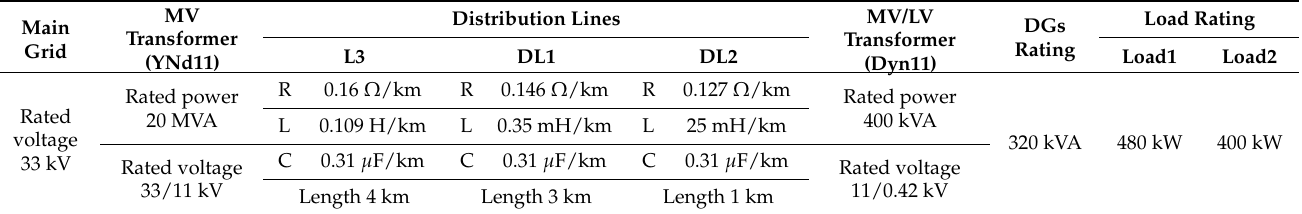
Figure 2. Single line diagram of the proposed system. Table 2. Parameters of the System.